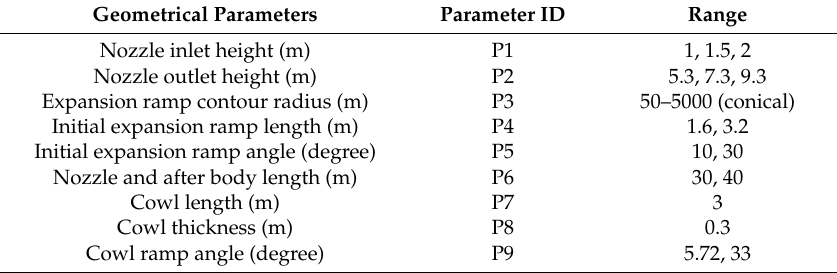
Table 1. 2D nozzle geometric parameters with corresponding values investigated.